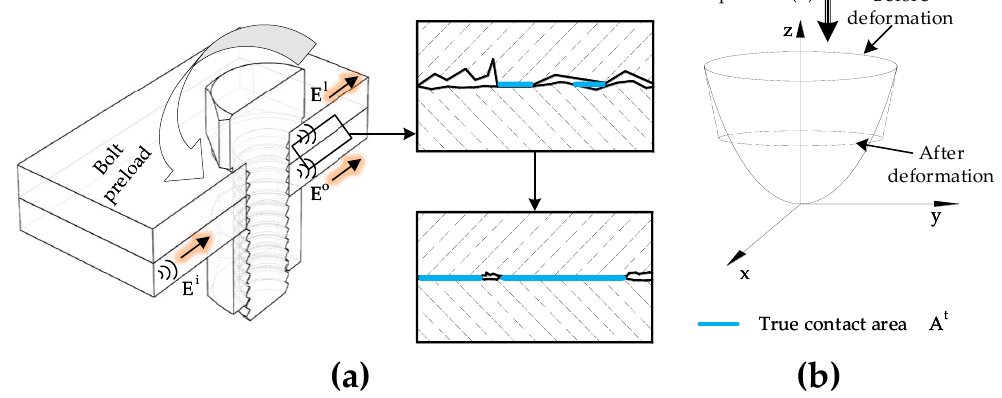
Figure 1. Changes of contact conditions at the bolted joint: ( a ) bolted joint prototype and microscopic view of the contact area, and ( b ) geometry of single asperity